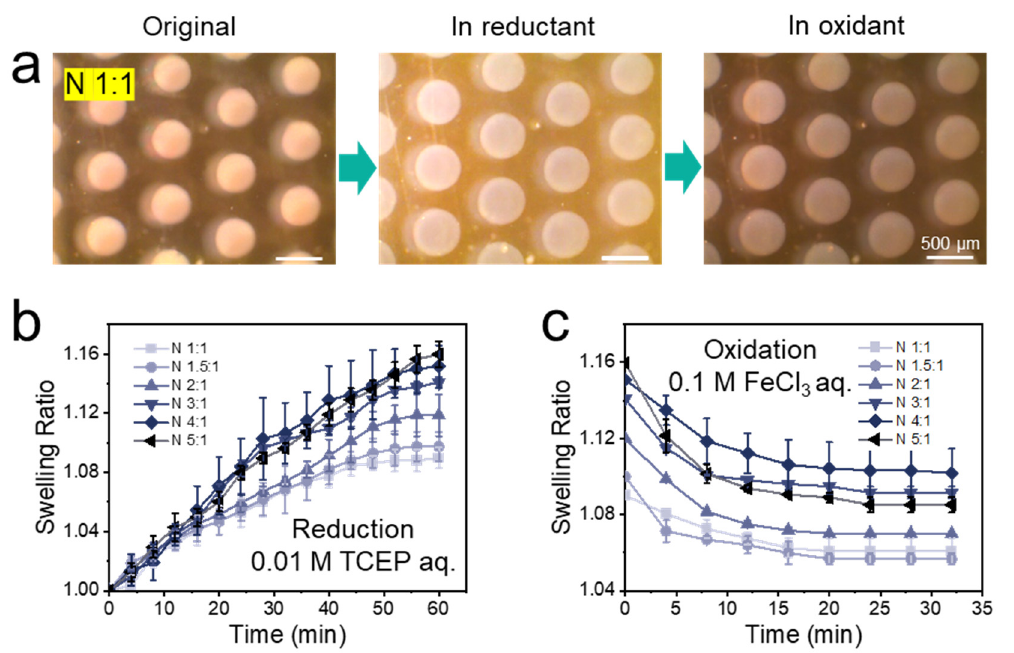
Figure 2. ( a ) Optical images of the original, the reduced (FR 1 µL min − 1 ) and the oxidized (FR 2 µL min − 1 ) N 1:1 hydrogel dots. ( b ) Swelling of PNiPAAm hydrogel dots with different molar ratios of cross-linkers BAC to BIS (from N 1:1 to N 5:1 hydrogel) in the microfluidic chip when 0.01 M TCEP aqueous solution perfused. ( c ) Shrinking of PNiPAAm hydrogel dots with different molar ratios of cross-linker BAC to BIS (from N 1:1 to N 5:1 hydrogel) in the microfluidic chip when 0.1 M FeCl 3